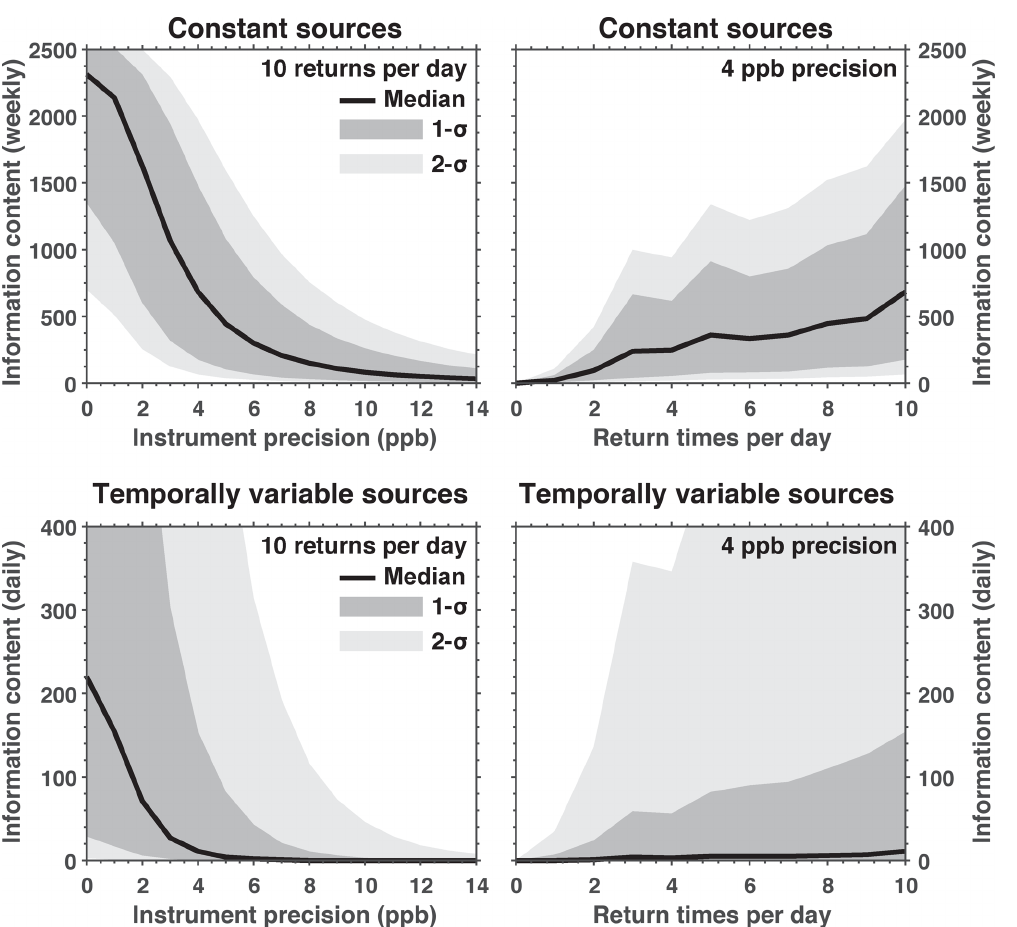
Figure 9. Information content I as a function of the instrument precision (left column) and the sampling frequency per day (right column) for a satellite with a pixel resolution of 2.7 × 3.0km 2 . Top row is for Case 1 where the sources are assumed to be temporally invariant and bottom row is for Case 2 where the sources are temporally variable. Solid black line is the median information content. A 4ppb model error is included; see Sect. 3. Uncertainty is from randomly sampling e i from the eigenvalues of the EDF